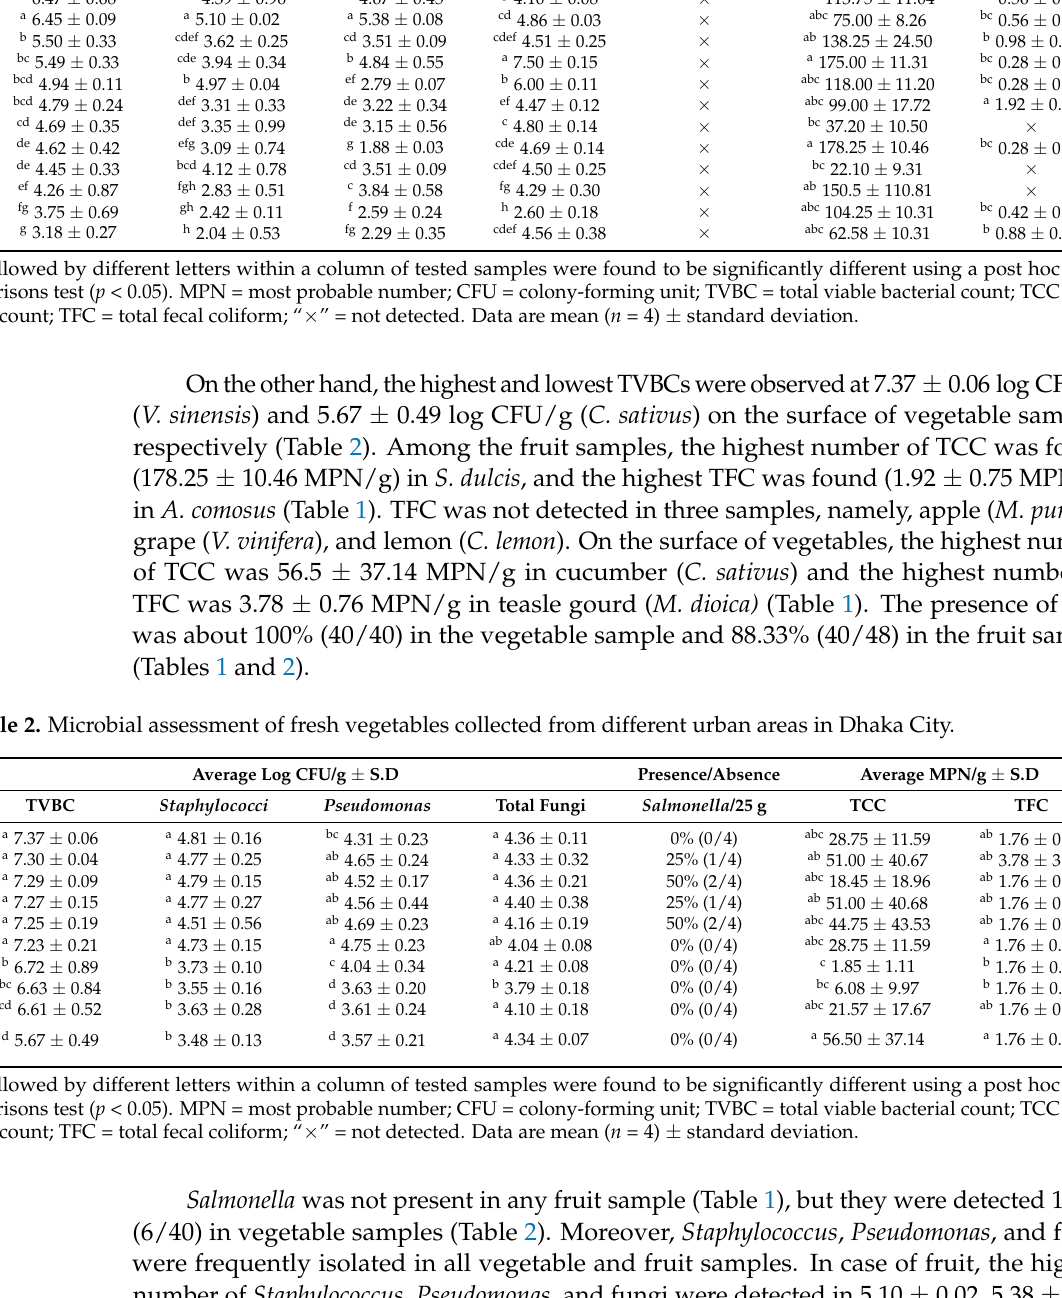
Table 1. Microbial assessment result of fresh cut fruit from different outlets in Dhaka City. Average Log CFU/g ± S.D Presence/Absence Average MPN/g ± SD Tested Samples TVBC Staphylococci Pseudomonas Total Fungi Salmonella /25 g TCC TFC